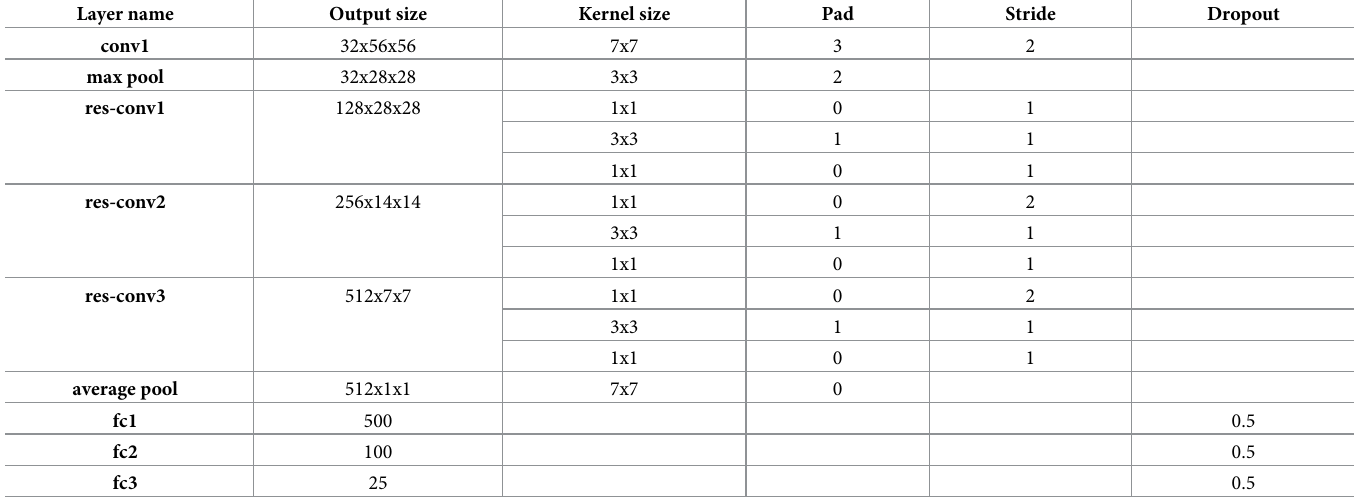
Table 1. Architectures of the SC-CNN